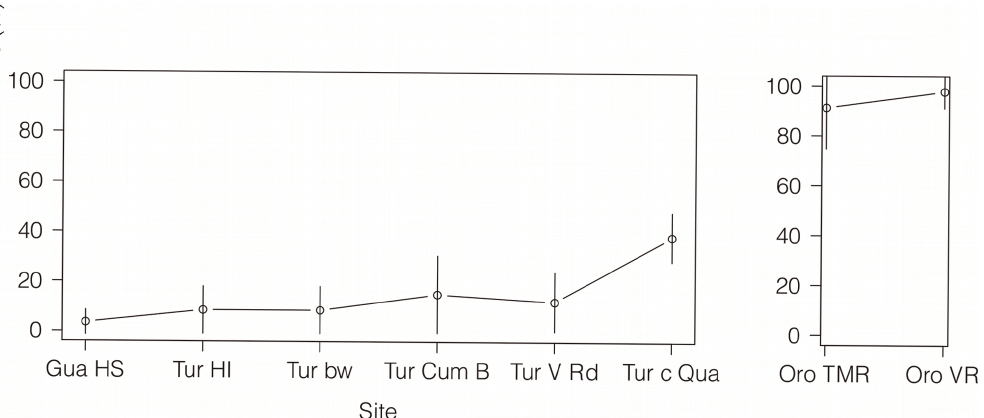
Figure 5. Percentage of SNPs from re-sampling the Turure river. The amount of native Turure and Oropuche allele frequencies estimated at four different loci with 14 SNPs compared to the invading Guanapo allele frequencies. The percentage of the Oropuche state of all SNPs per site was taken in order to illustrate the change of genetic composition across the river Turure. Two sites at the Oropuche were sampled to compare the Turure results to a likely original genotype. N=10 fish per site, except Oropuche Toco Main Road: n=3. HS: Haskins’s source; HI: Haskins’s introduction. Error bars represent 95% CI. doi:10.1371/journal.pone.0038404.g005 PLoS ONE |